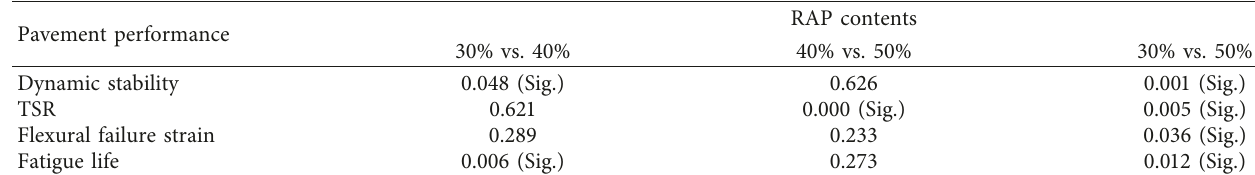
Figure 6: Influences of the DOB on the pavement performance. (a) Dynamic stability; (b) moisture stability; (c) low-temperature per- formance; (d) fatigue performance. Table 16: ANCOVA results of slope difference for different RAP contents.